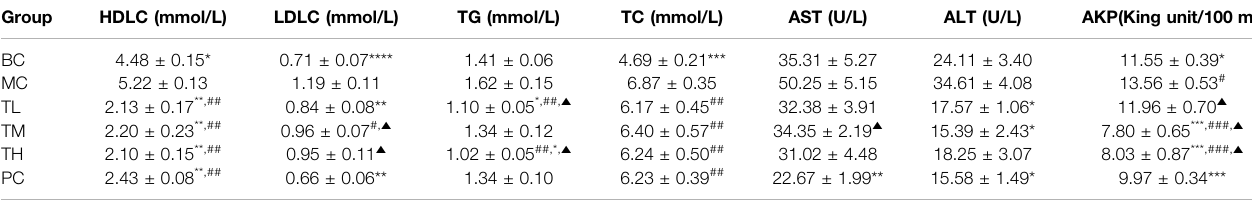
TABLE 1 | Comparison of serum biochemical indexes of mice in each group after 5 weeks of gavage ( ‾ x±se, n = 9). Group HDLC